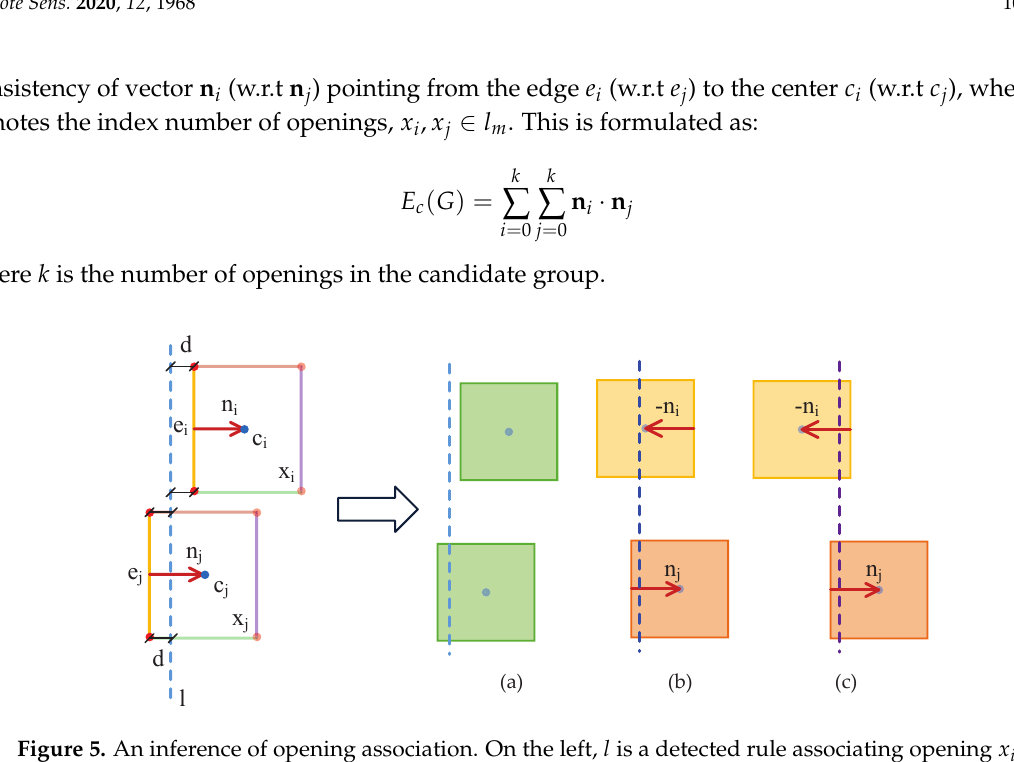
Figure 5. An inference of opening association. On the left, l is a detected rule associating opening x i and x j . ( a ) Reconstructed openings in green are associated because they follow the same left alignment; ( b ) Association failed since the center–left and right–center alignment differ in the vector pointing to the center of opening; ( c ) Similarly with ( b ), right–left aligned with opposite normal vectors fails the association (marked in yellow and pink